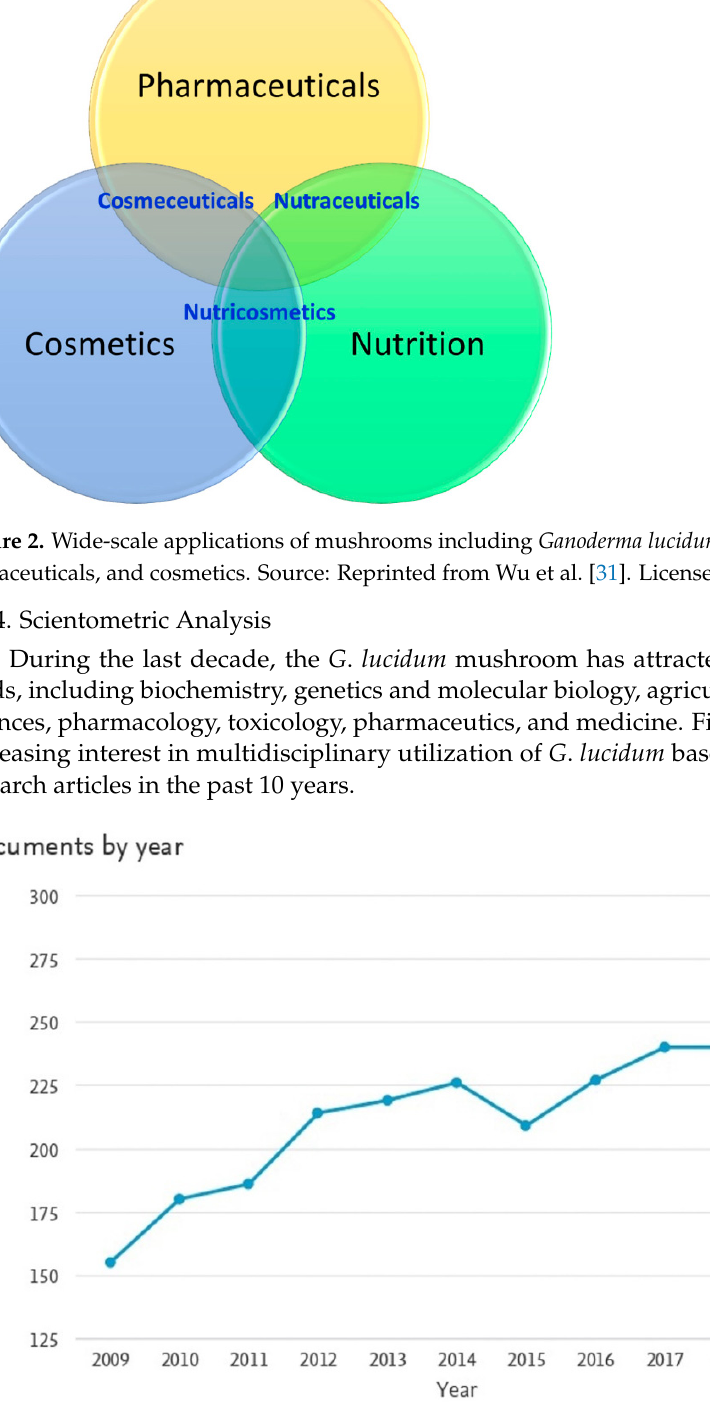
Figure 3. A scientometric analysis of increasing interest in Ganoderma lucidum over the last 10 years. Reprinted with permission from Scopus. 2020, Elsevier.